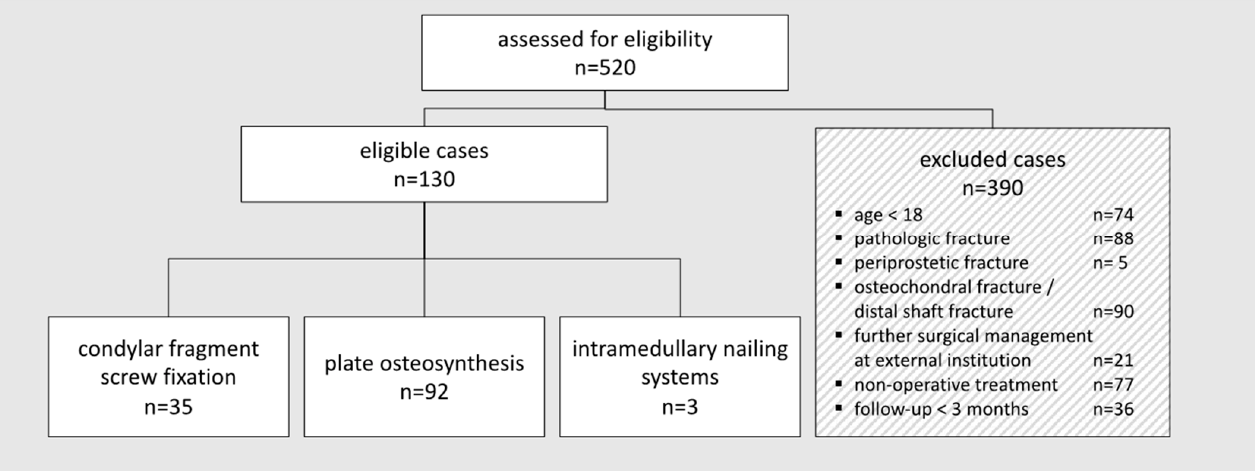
Figure 1. Flow chart calculating the eligibility of included patients.